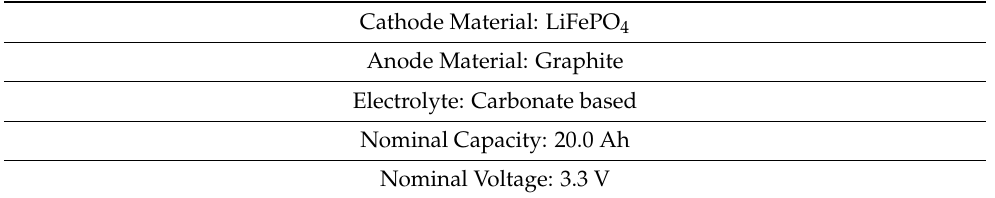
Table 1. Lithium-ion pouch cell